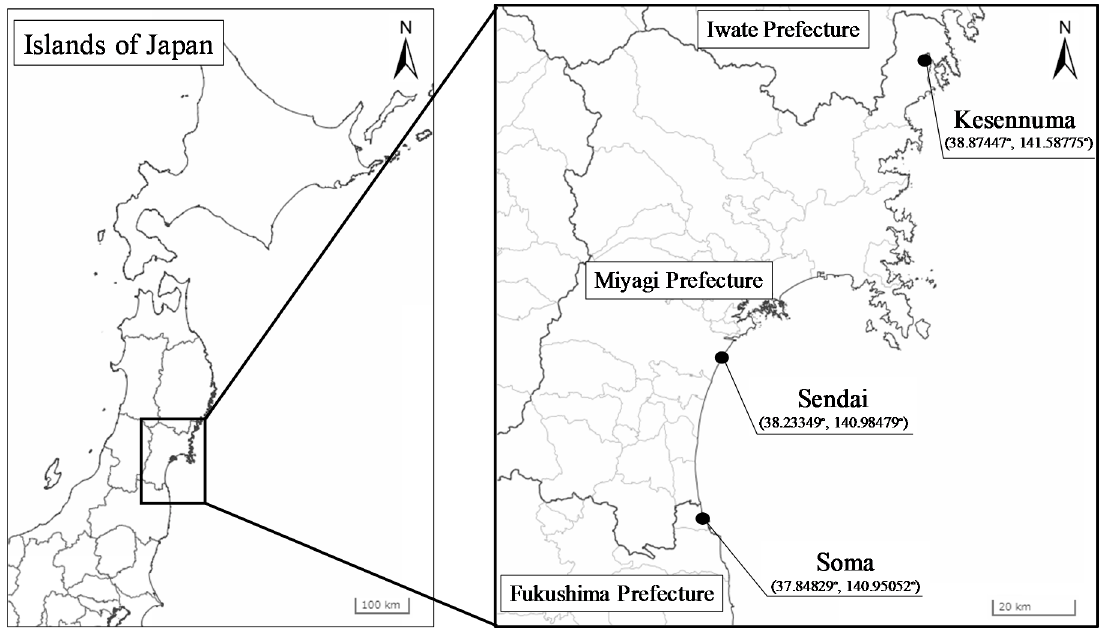
Figure 3. Locations of the target buildings.